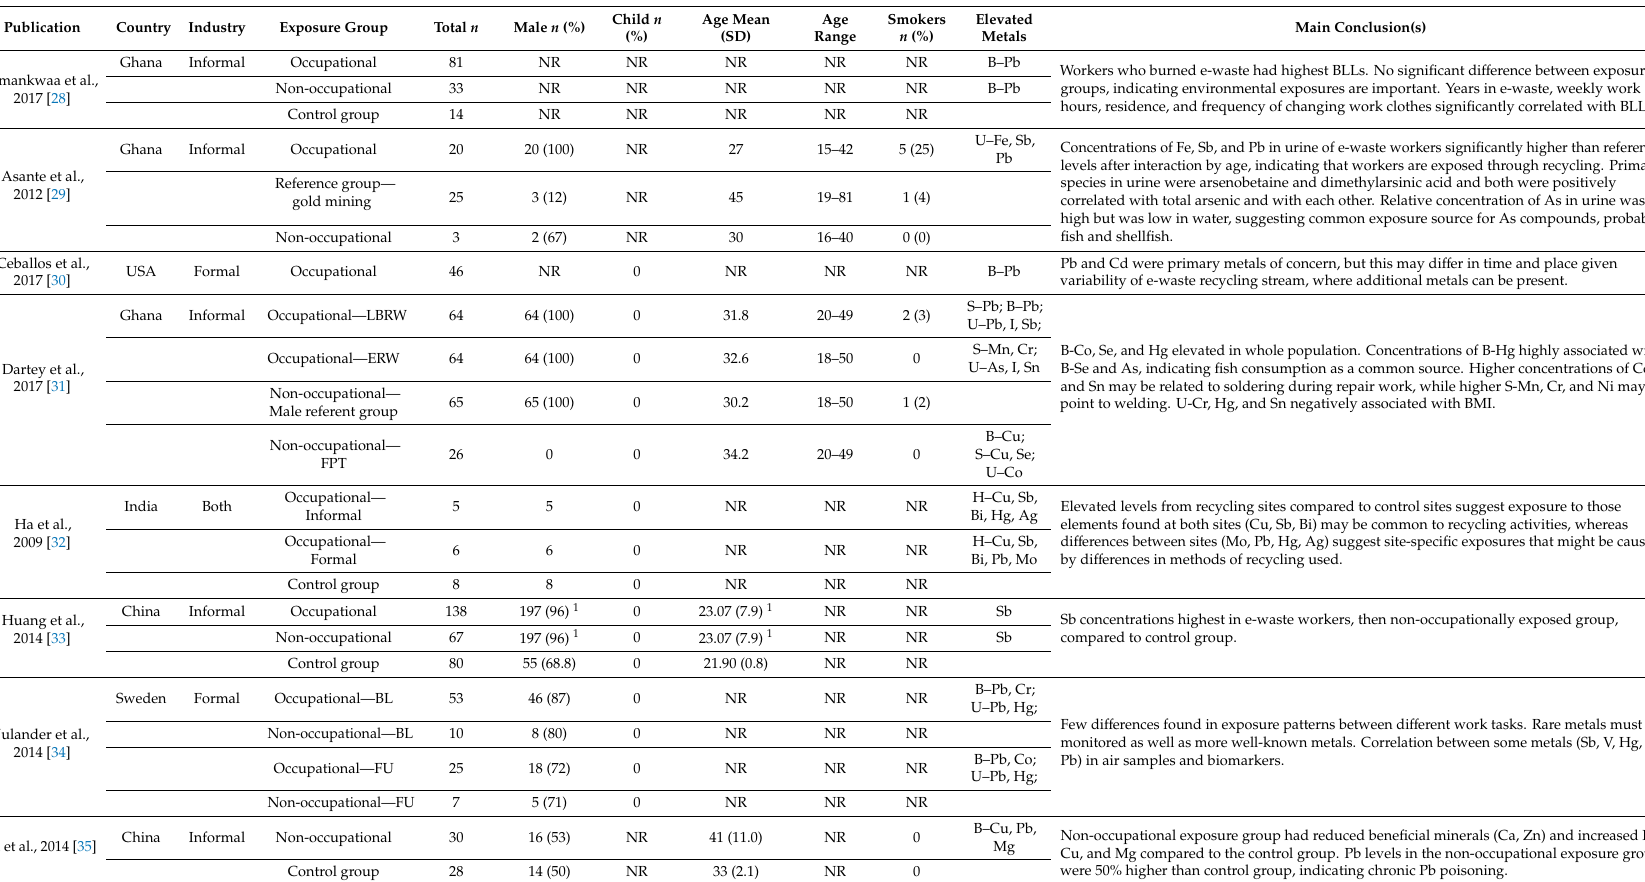
Table 2. Summary results of the study set, including exposure groups, demographics, results, main conclusions, and conclusions from sample types other than metal